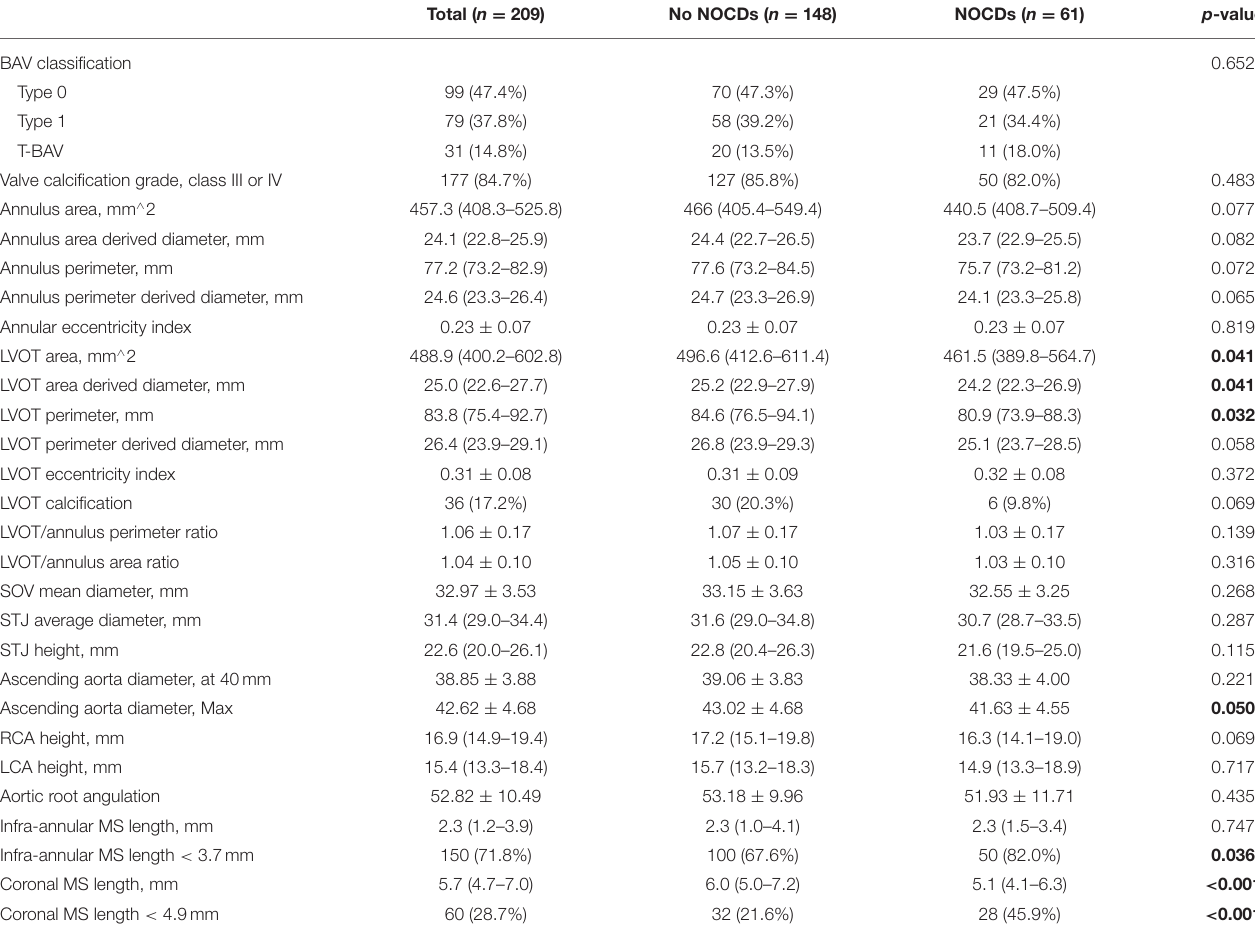
TABLE 2 | Computed tomography characteristics of bicuspid aortic stenosis patients and